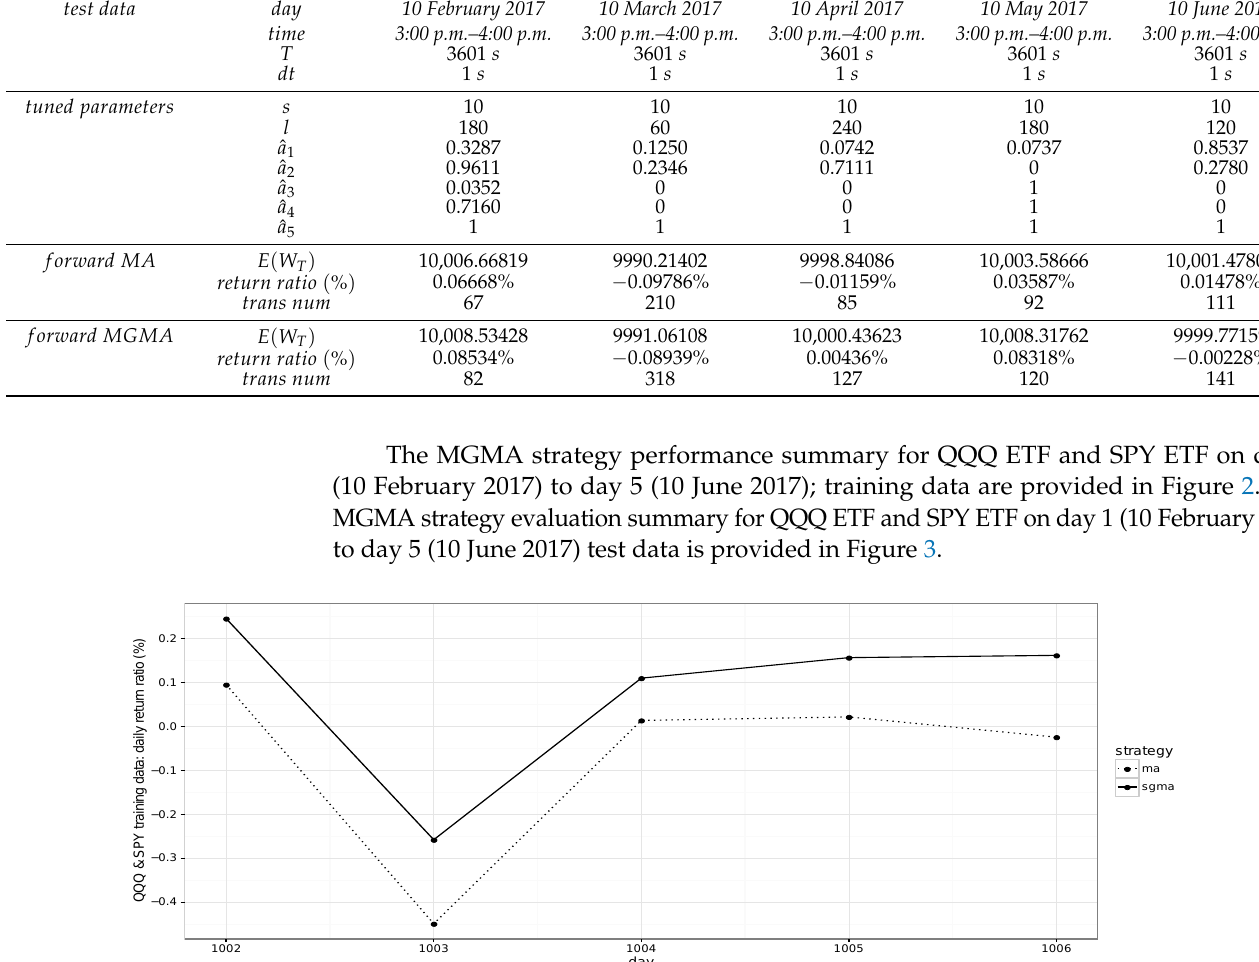
Table 9. Case 1—MGMA strategy evaluation summary for QQQ ETF and SPY ETF on day 1 (10 February 2017) to day 5 (10 June 2017) test data. test data